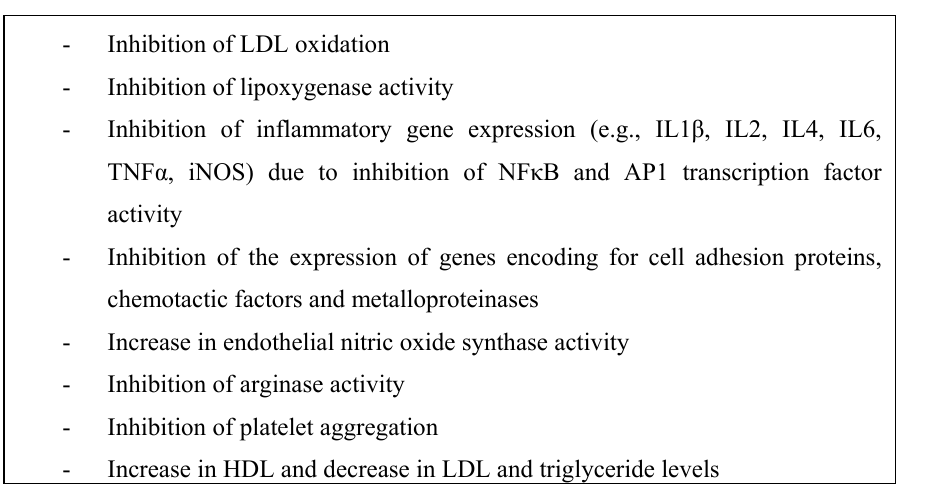
Table 3. Potential mechanisms by which polyphenols from cocoa may affect vascular health.